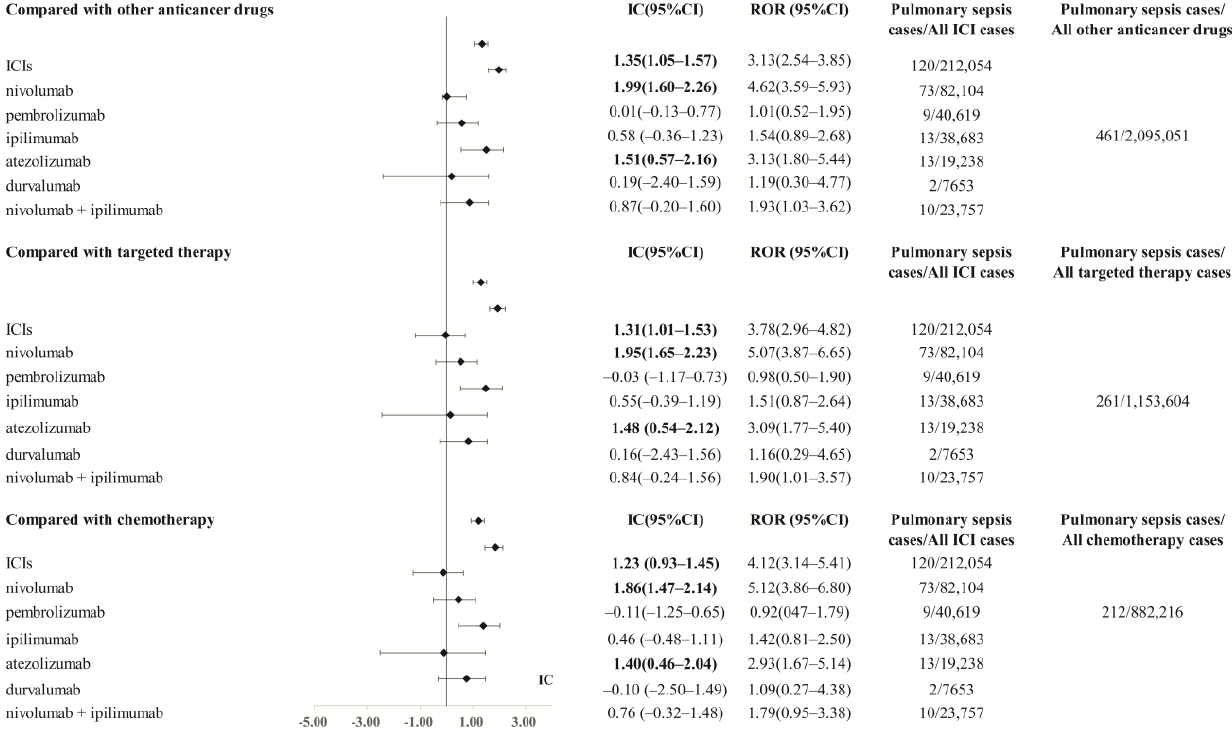
Figure 1. The comparison of pulmonary sepsis signal between ICIs and controls (other anticancer drugs, targeted therapy, chemotherapy) in FAERS database. The list of the control group (targeted therapy and chemotherapy) was extracted from NCCN guidelines for ICIs ’ indication. More details